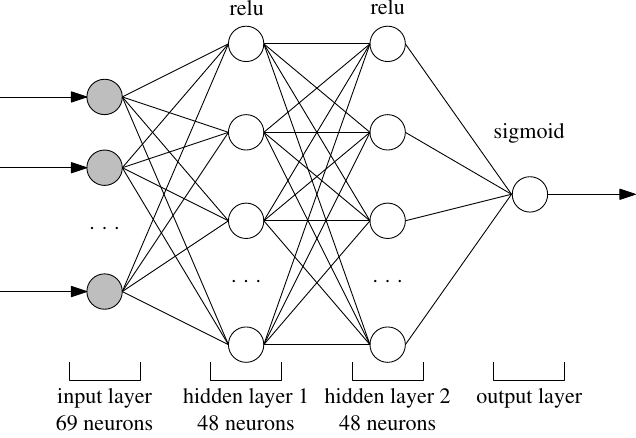
Figure 3. ANN structure for transaction emails classification model. Table 4. Classification report for model shown in Figure 3. Precision Recall